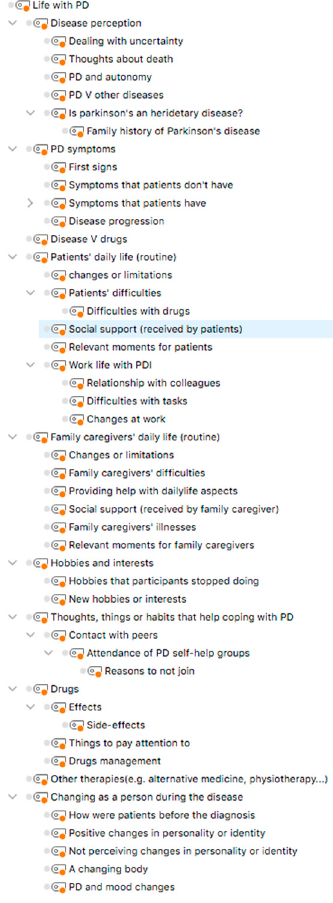
Figure A2. Extract of the coding three.